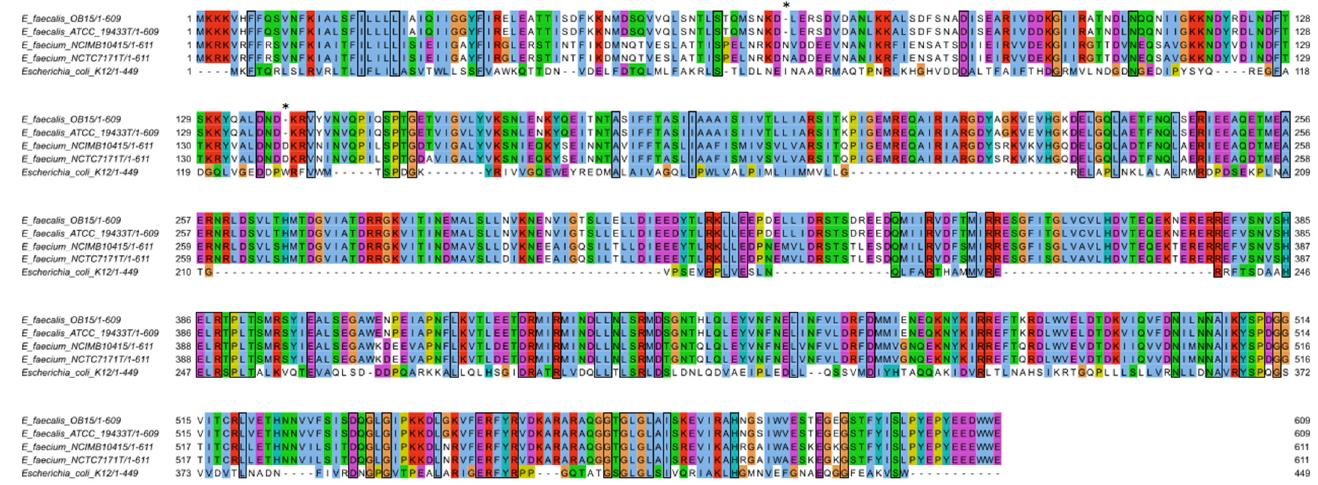
Figure 6. Multiple sequence alignment of E. faecium NCIMB10415’s VicK (WalK) amino acid sequence with QseC from E. coli strain K-12 and similar sequences from E. faecalis and E. faecium . Shared amino acids are boxed. Asterisks indicate indels at positions -70N and -140D by comparison to the E. faecalis sequences.